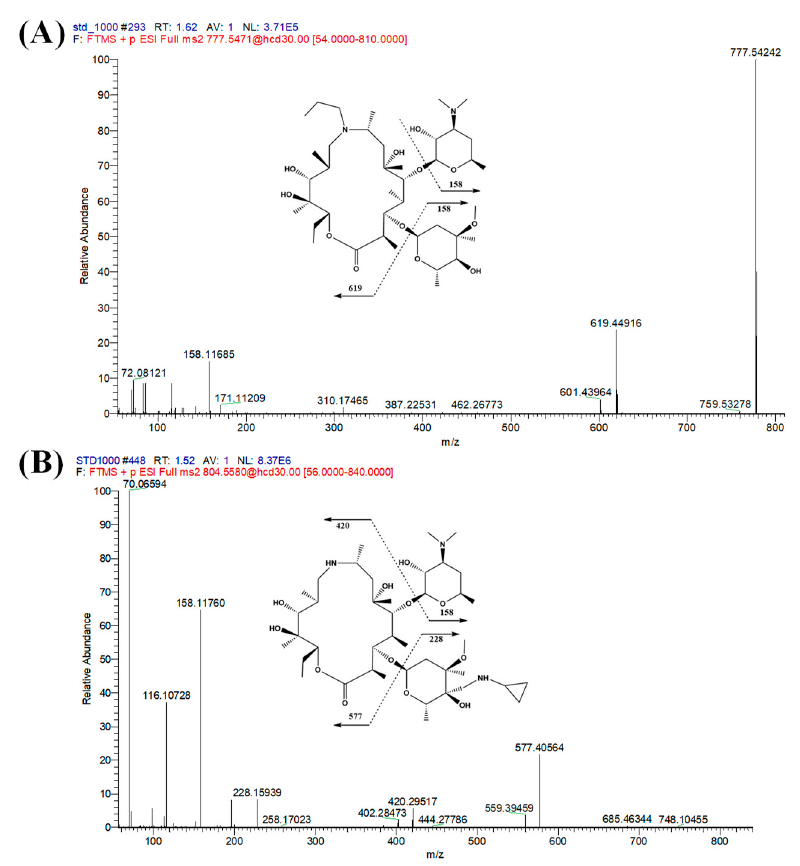
Figure 2. The mass spectra of gamithromycin (( A ) internal standard, IS) and lekethromycin ( B